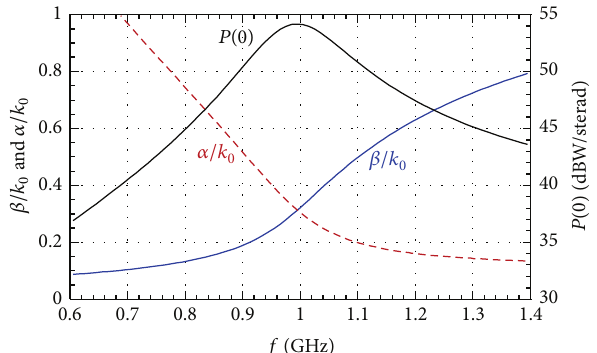
Figure 5: Dispersion curve of the supported TM leaky wave and power density radiated at broadside by a horizontal magnetic dipole on the ground plane as functions of frequency when the antenna thickness is 𝑏 = 𝜆 0 /70 at 𝑓 = 1 GHz. Other parameters: 𝐵 𝑓 = 11.14 .